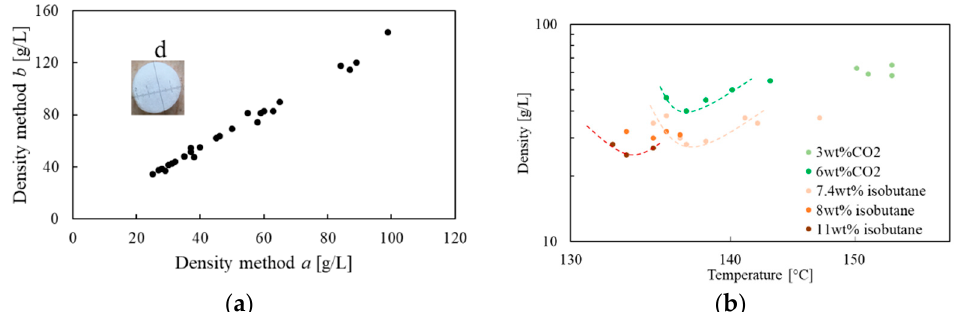
Figure 3. ( a ) Comparison between the density calculated with two methods; ( b ) density as function of foaming temperature. The dashed lines are neither a model nor a regression, they are guideline for eyes. They should help the reader identify the local minimum despite the scattered points.